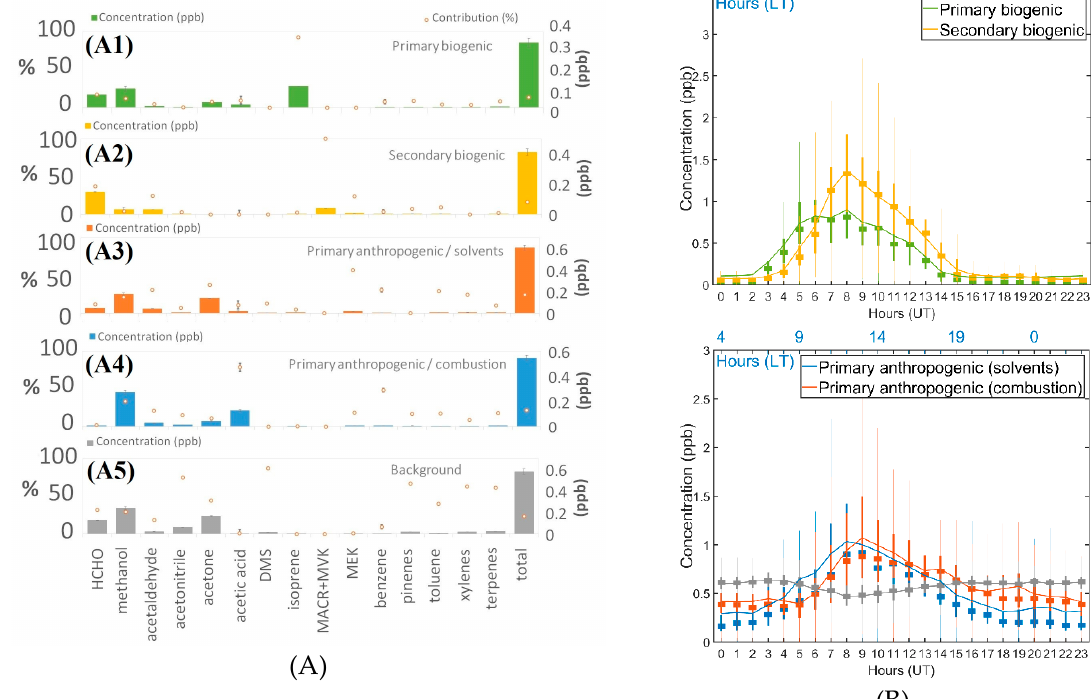
Figure 8. ( A ) Concentrations (bar chart) and percentage (orange dots) of the contribution of the five factors and their standard deviation (1 σ ) provided by the PMF. ( A1 ) Primary biogenic factor, ( A2 ) Secondary biogenic factor, ( A3 ) Primary anthropogenic / solvents factor, ( A4 ) Primary anthropogenic / combustion factor, ( A5 ) Background factor. ( B ) Daily boxplots of modeled sources from the five-factor solution. Solid line, average concentration is the solid line; squares, medians. The bottom and top edges of the box indicate the 25th and 75th percentiles, respectively. The whiskers extend to the most extreme data points.